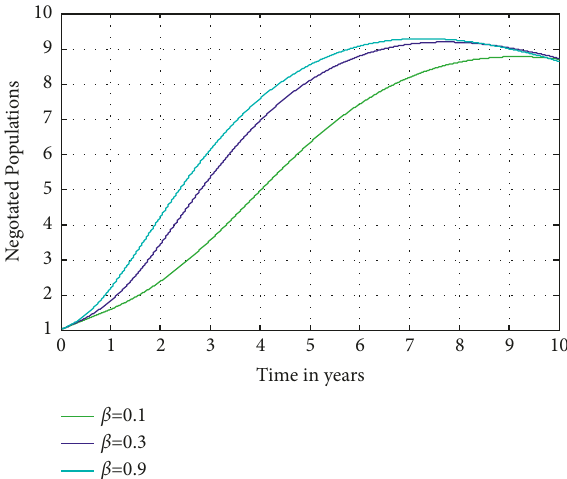
Figure 4: Effect of the diffusion rate β on the negotiated indi- viduals.